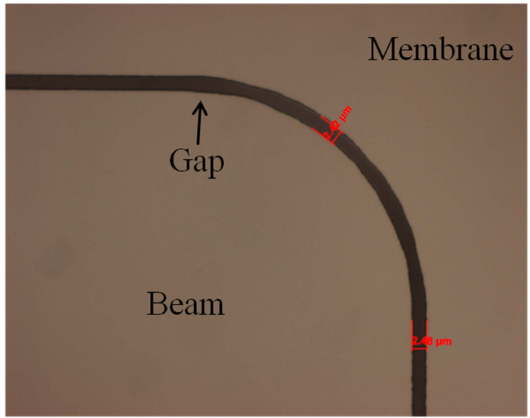
Figure 6. Filleted free end corner of a cantilever to reduce stress in the structure caused by having a sharp right angle. The ~3 µ m gap was maintained throughout the corner and along the beam’s edge.